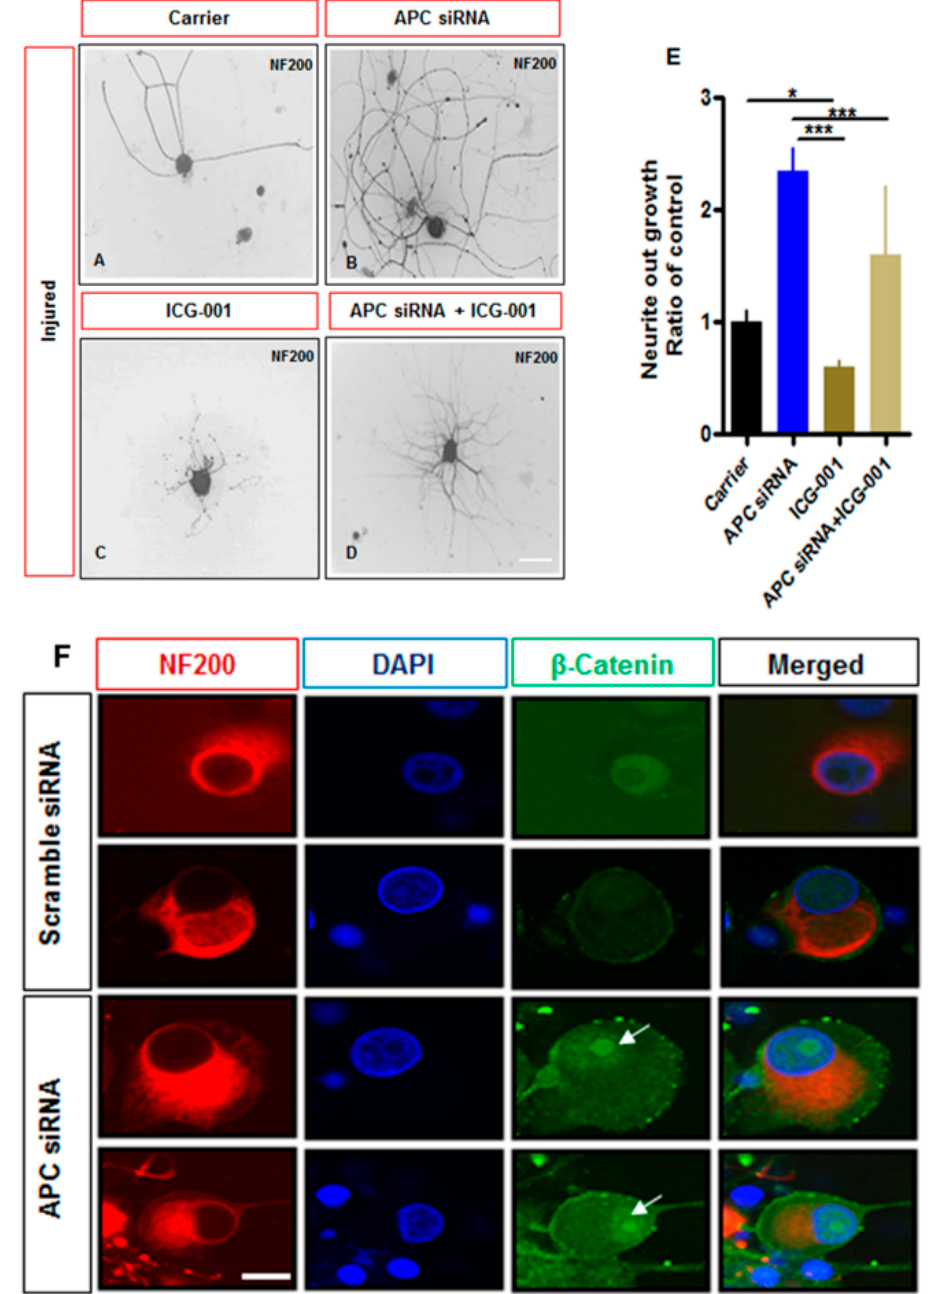
Figure 6. APC participates in the degradation of the signaling molecule β -Catenin. Knockdown of APC using siRNA was associated with increased outgrowth of adult DRG sensory neurons in vitro ( A – E ). ICG-001, a selective inhibitor of β -catenin attenuated the impact of APC siRNA on neurite outgrowth. APC knockdown by siRNA was also associated with repositioning of β -Catenin to neuron nuclei ( F , arrow). Scale bar = 50 µM. * p < 0.05, *** p < 0.001. The Figure is reproduced with permission from Duraikannu et al. and Springer Nature [141].